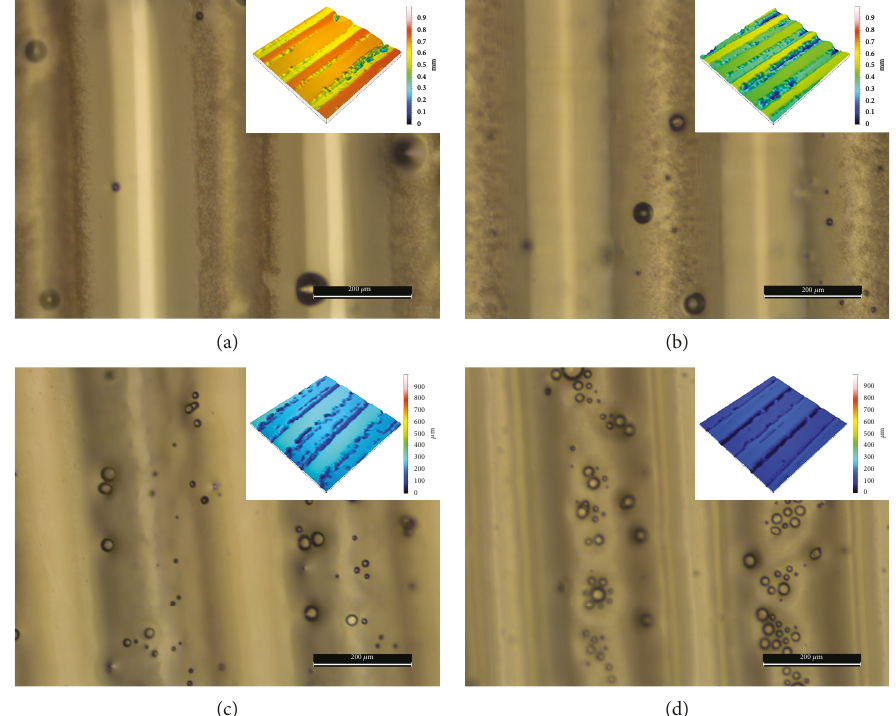
Figure 2: Optical micrographs of 4 laser-processed PET samples with increasing scanning speed between the parallel laser processing lines. (a) 100mm/s; (b) 200mm/s; (c) 300 mm/s; (d) 400 mm/s. All samples have been processed at 15% power and at 400 μ m spacing. The insets are CCI surface maps that have been set to the same z scale, and horizontally the scale bar is equal to 200 μ